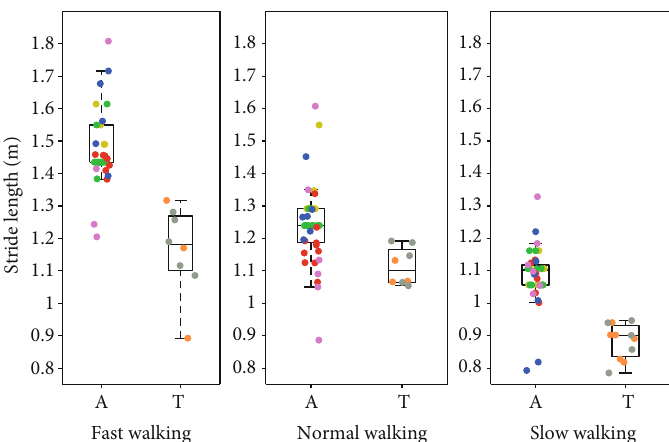
Figure 17: Stride length of participants with intact limbs and prosthesis users at three speeds with the normal speed being their preferred speed. The data from participants with intact limbs is shown on the left (A) and transfemoral prosthesis user data is shown on the right (T) in each pair. The fi gure shows the median, along with a box that bounds the fi rst and third quartiles of the data, and whiskers that bound the entire range of the data (apart from outliers). Moreover, the scatter plot shows the average stride length of each trial. The data for each subject are color-coded: yellow = AB01 , green = AB02 , red = AB03 , blue = AB04 , purple = AB05 , brown = PR01 , and gray = PR02 .